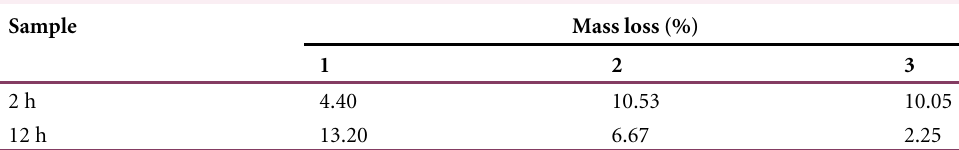
Table 4 Mass loss (%) of Y(OH) 3 at samples of 2 and 12